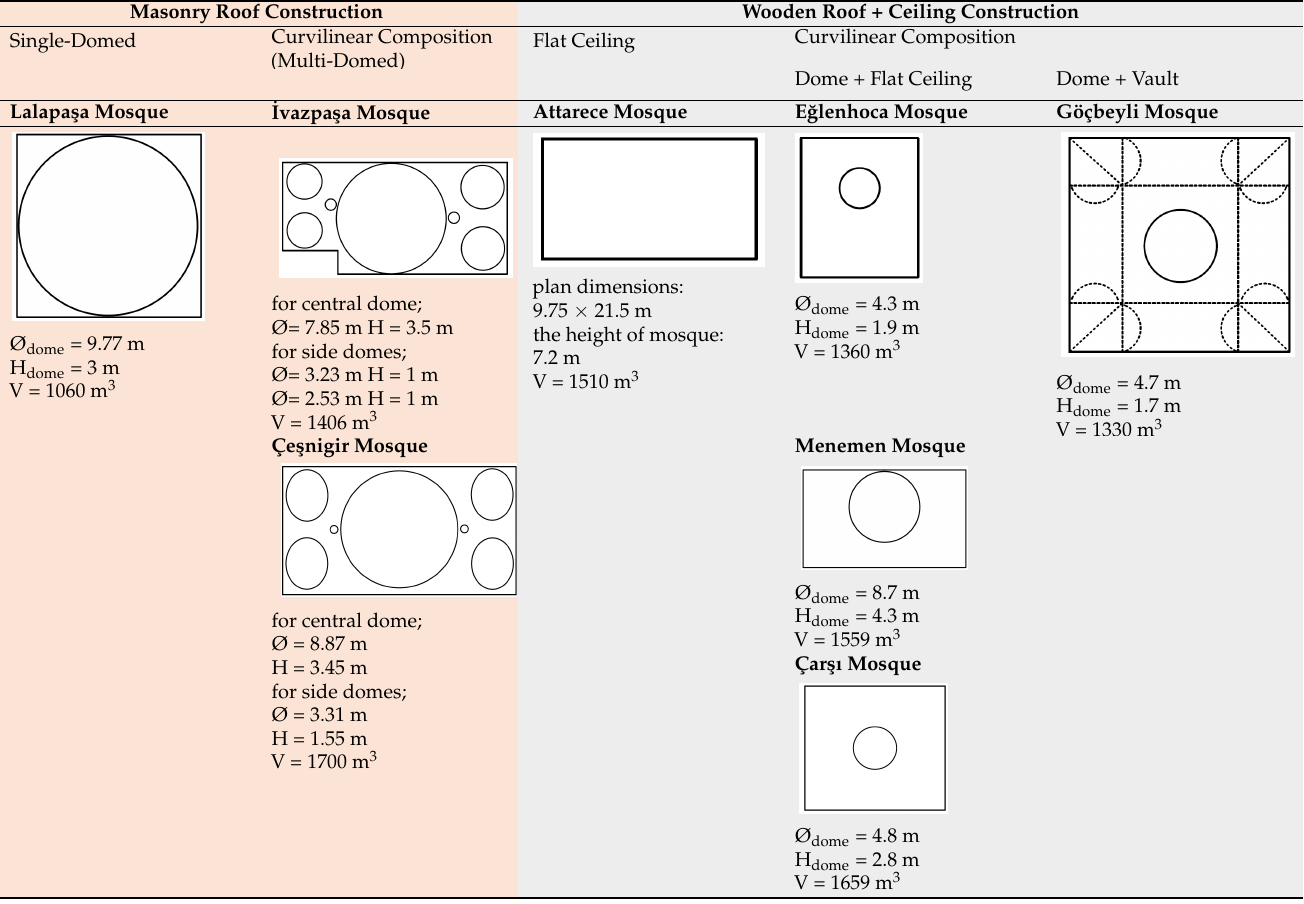
Table 9. The classification of mosques in the study according to features of the roof/ceiling systems facing the interior. Masonry Roof Construction Wooden Roof + Ceiling Construction Single-Domed